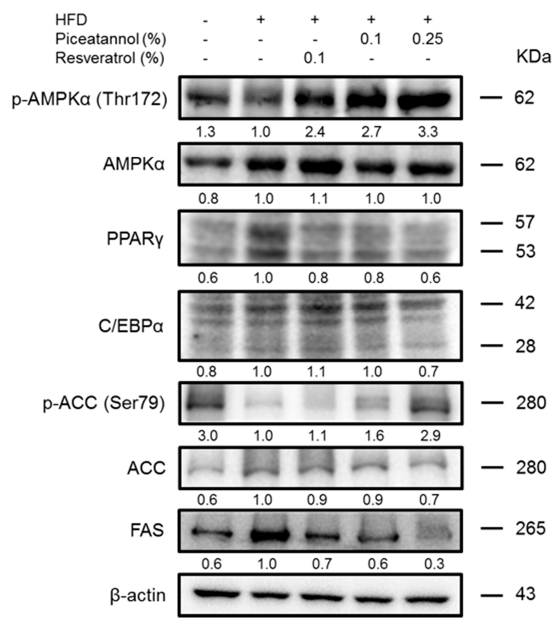
Figure 6. Effect of piceatannol supplementation on hepatic adipogenic protein in HFD-fed C57BL/6 mice. Hepatic adipogenic protein levels were evaluated by western blot analysis. The values under each lane indicated relative density of the band normalized to β -actin. The western blot is representative of at least three independent experiments.